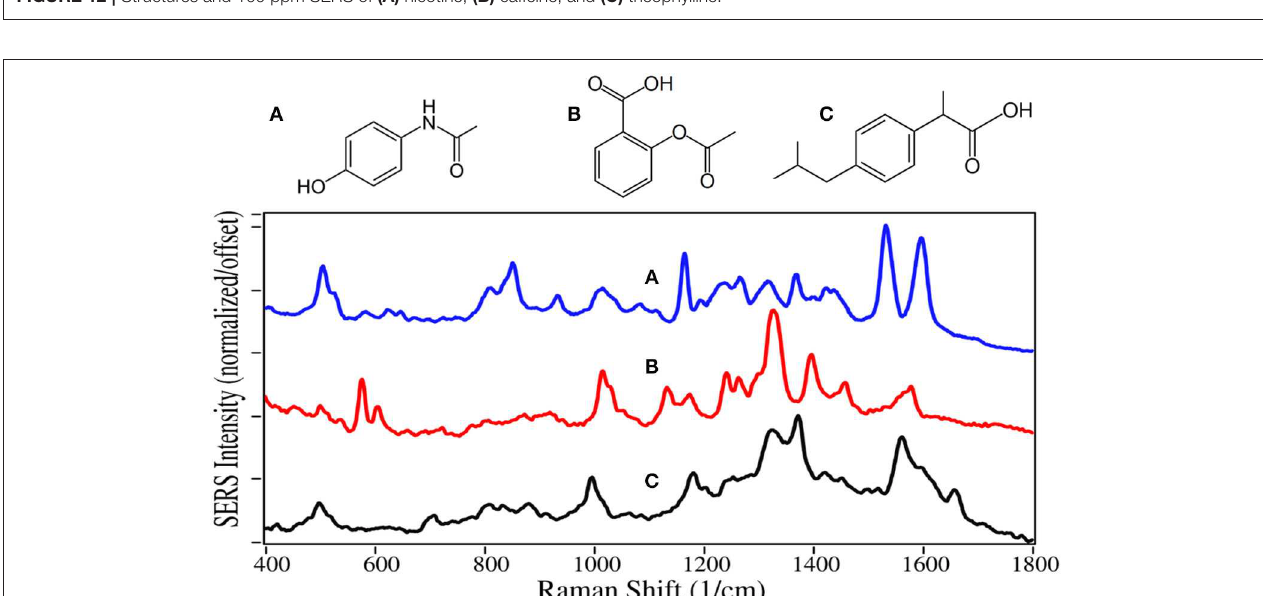
FIGURE 13 | Structures and 100 ppm SERS of (A) acetaminophen, (B) aspirin, and (C) ibuprofen.